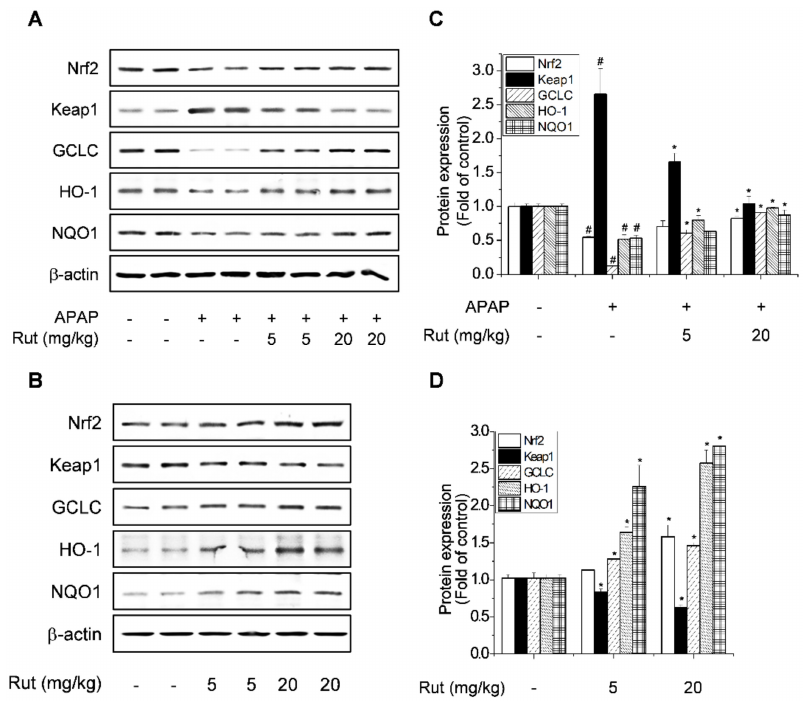
Figure 5. Protective effect of Rut as seen by the mitigation of the APAP-mediated reduction in antiox- idant enzymes. Hepatic protein levels of Nrf2, Keap1, GCLC, HO-1, and NQO1 were determined using western blotting ( A , B ). Protein level was analyzed using ImageJ software. Relative expres- sion of the target protein was compared using β -actin as a control ( C , D ). Results are indicated as means ± SD ( n = 10). # Significantly different from the control ( p < 0.05). * Significantly different from the APAP-treated group ( p < 0.05).